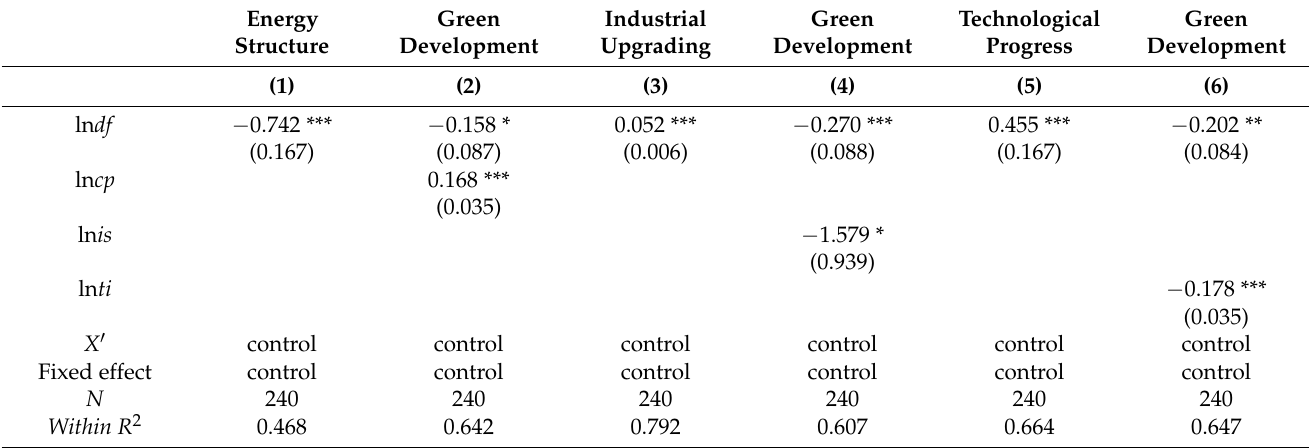
Table 6. Test results of the mediation effect of digital finance on green